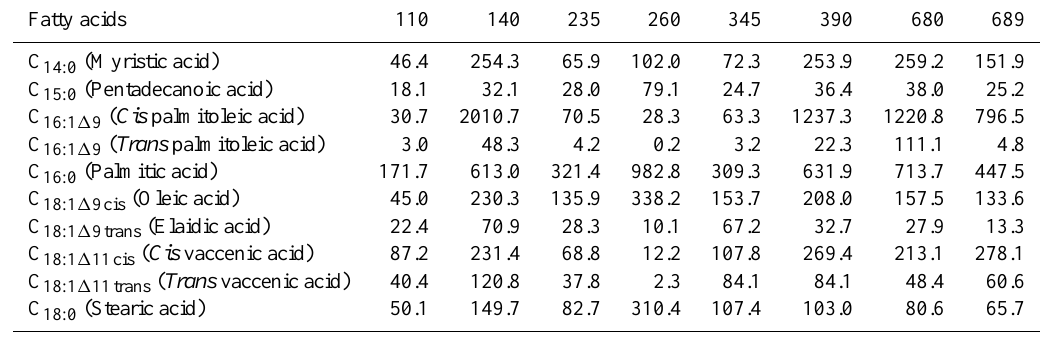
Table 2. Fatty acid content (µgg − 1 ) of the sediments investigated.